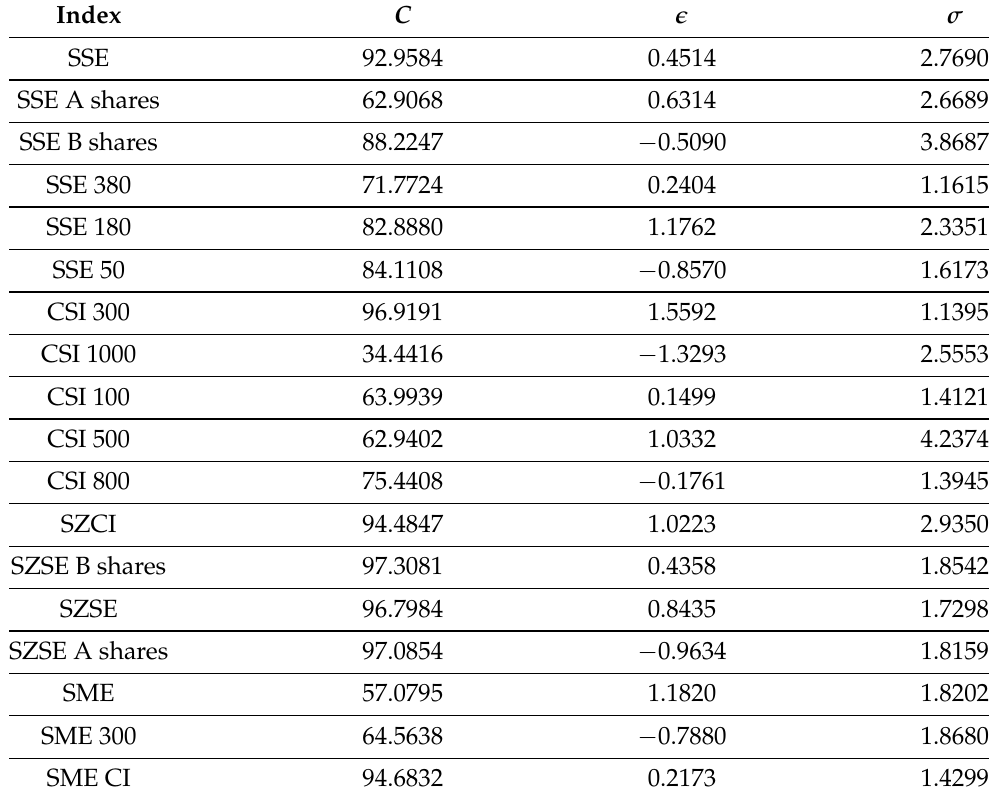
Table 8. SVR parameters obtained by mid-term bat algorithm optimization.